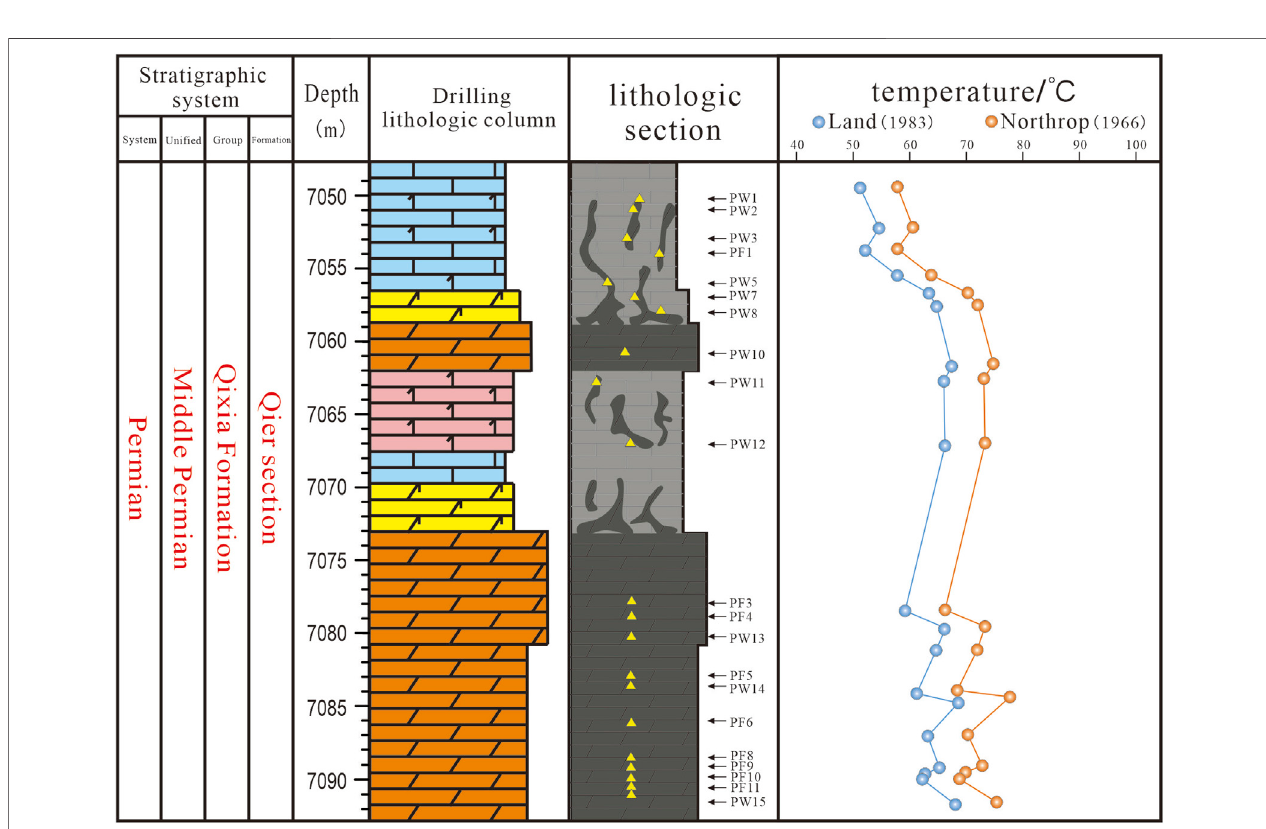
FIGURE 9 | Longitudinal distribution of the calculated diagenetic temperature of dolomites of Qixia Formation in Shuangyushi Region.